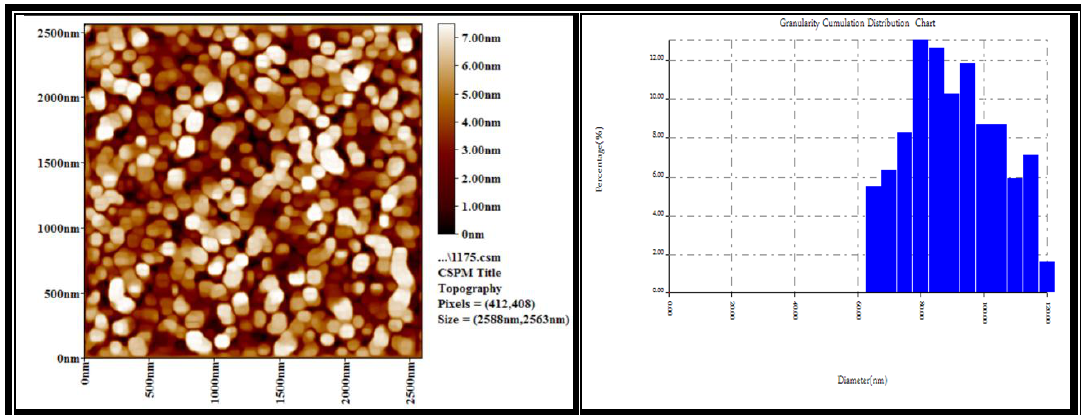
Fig.7: Surface roughness and histogram of Cr-doped TiO